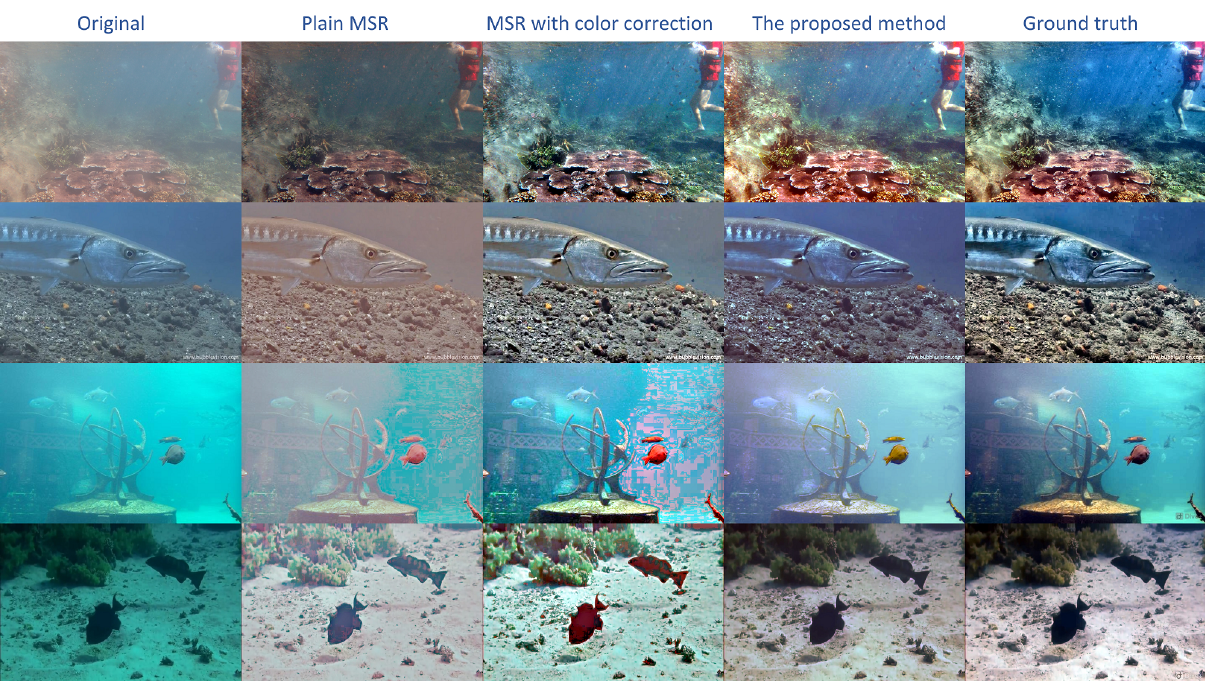
Figure 4. Visual comparison of the enhanced outputs produced by two MSR-based methods and the proposed method. Original images and their corresponding ground truth images are from UIEB test